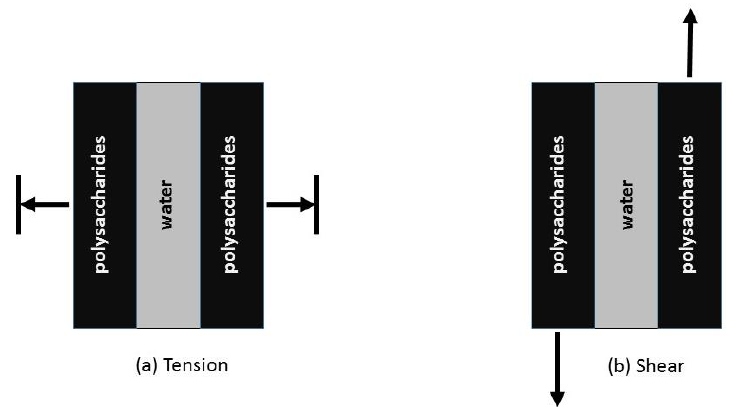
Figure 10. Properties of water in the cell wall. ( a ) A water layer impairs the separation of two polysaccharide elements through surface tension; ( b ) but promotes sliding when the polysaccharides are under shear pressure.